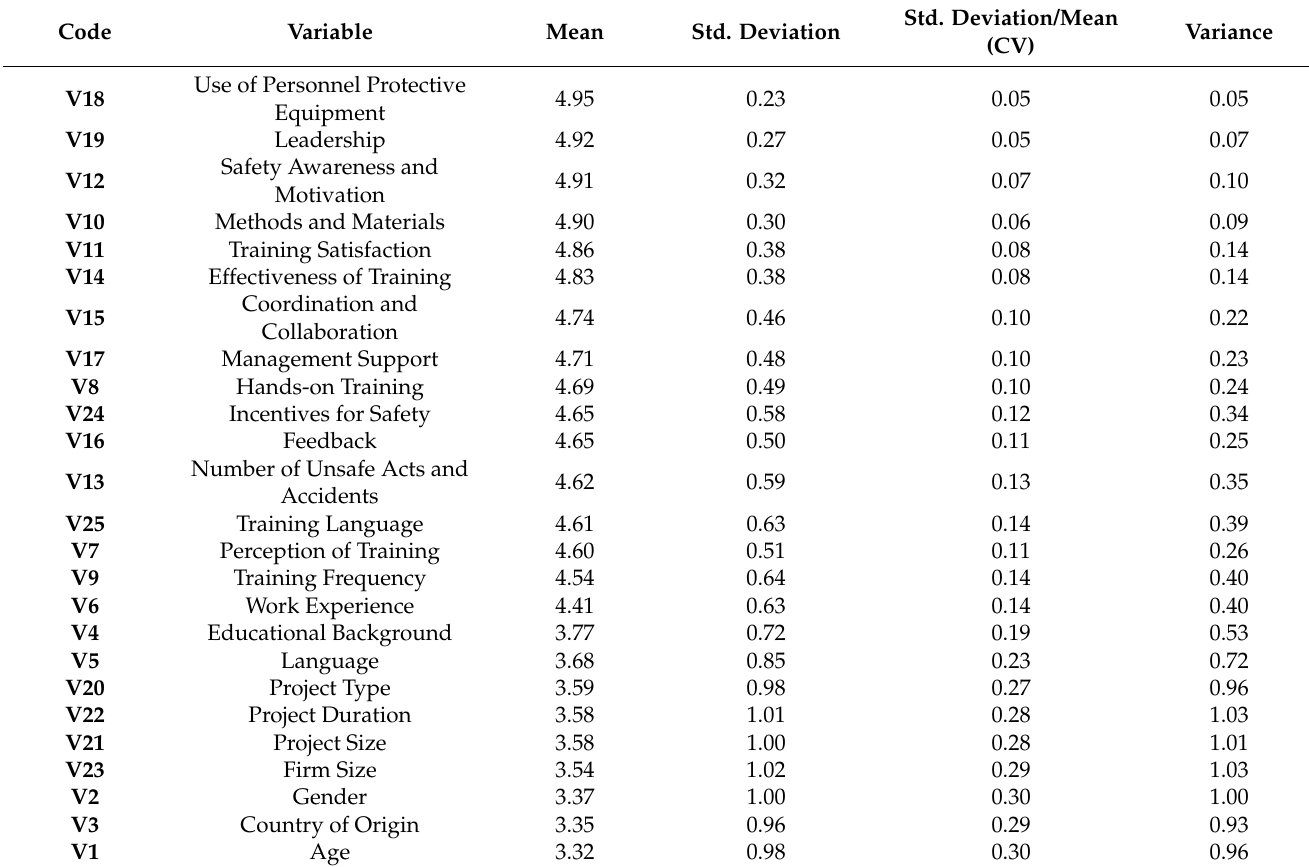
Table 3. Descriptive Statistics of Safety Training